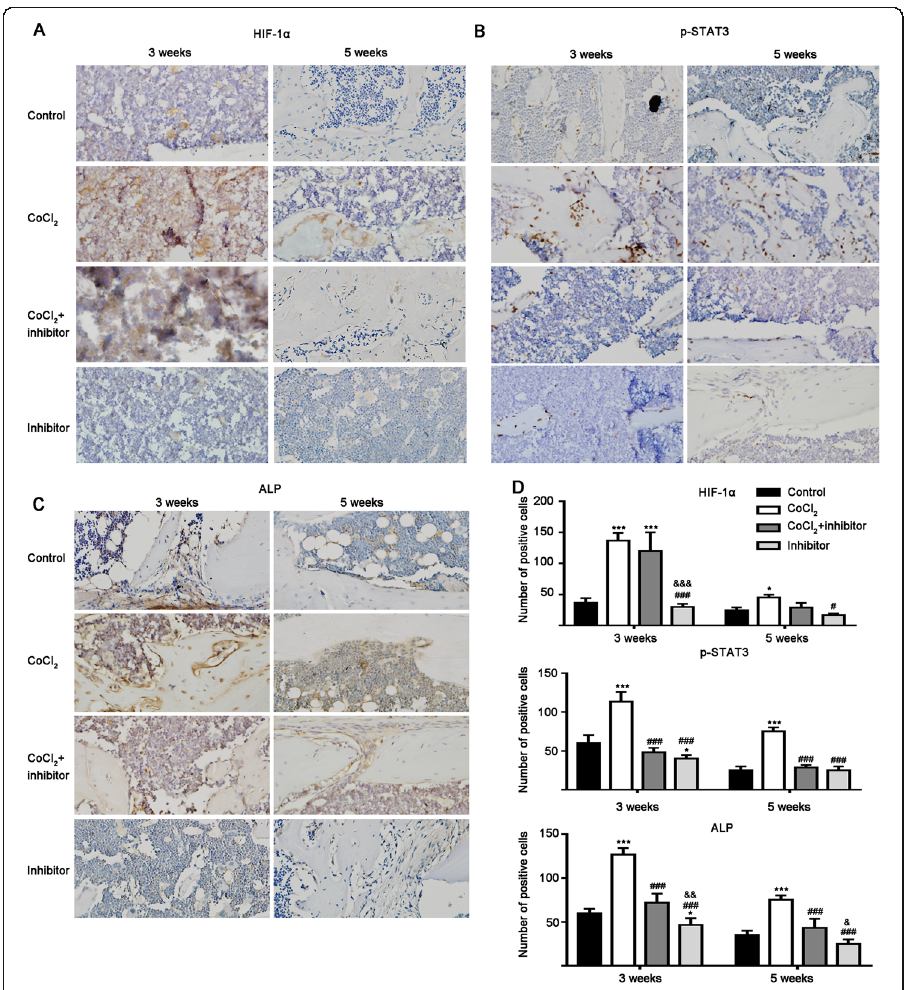
Fig. 7 Representative immunohistochemistry images for proteins in bone defect tissue sections. a – HIF-1 α . b – p-STAT3. c – ALP. d – Quantitative analysis of HIF-1 α , p-STAT3 and ALP protein expression in bone defect area. Significant effect of the treatment compared to the control group: * p < 0.05 and *** p < 0.001; the